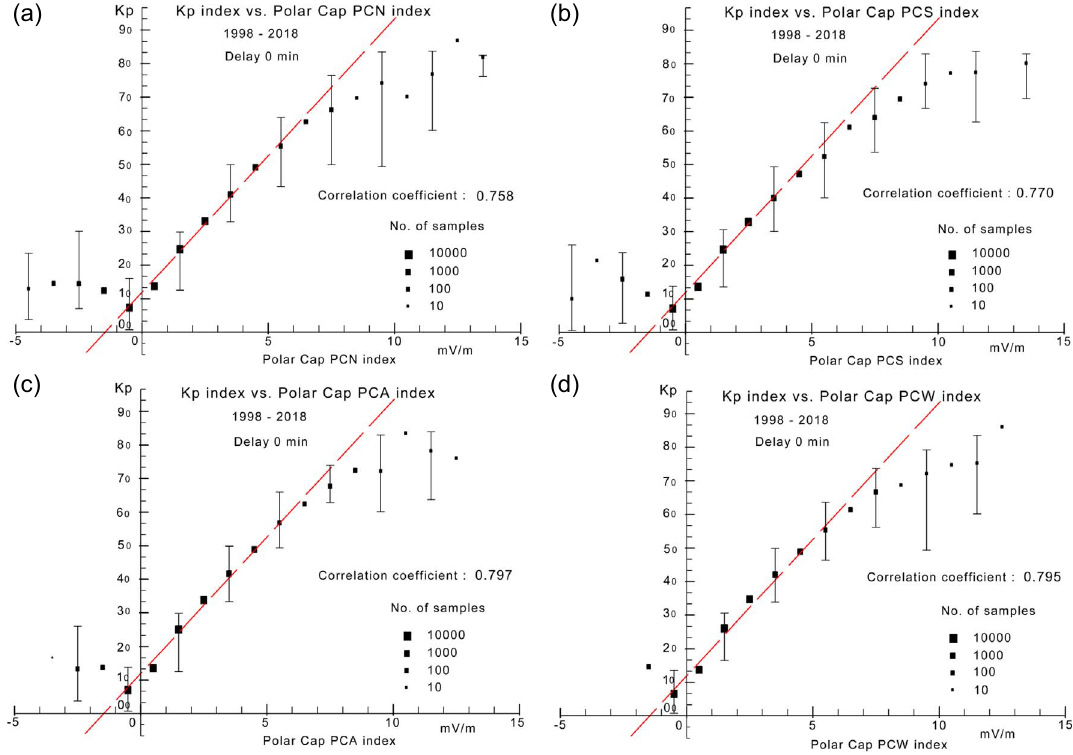
Fig. 8. Display of Kp against PCN (a), PCS (b), PCA (c) and PCW (d) in the format of Figure 7b. The dashed red lines are illustrative only and placed to fi t the positive PC index values. Note the upturns for negative PC index